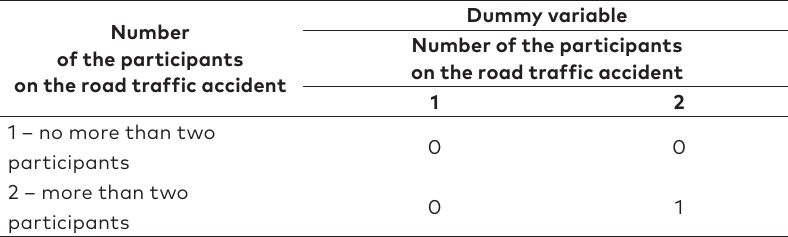
Table 2. Rearrangement of variables